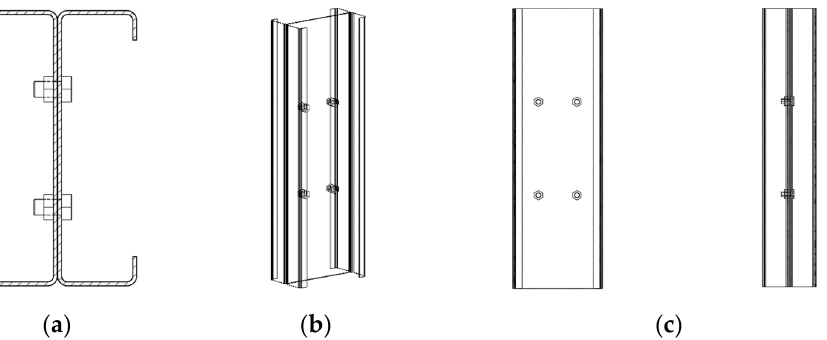
Figure 1. Diagram of the C-steel combined I-section column ( a ) Cross section; ( b ) 3D diagram; ( c ) Side-view and front view diagram.